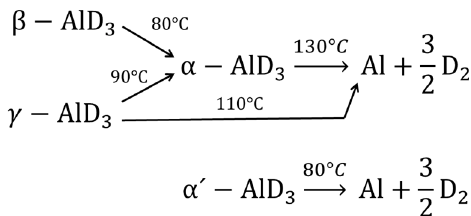
Figure 3. Dehydrogenation pathway of several deuterated alanes (adapted from [62]). Table 1. Crystallographic data of alanes.